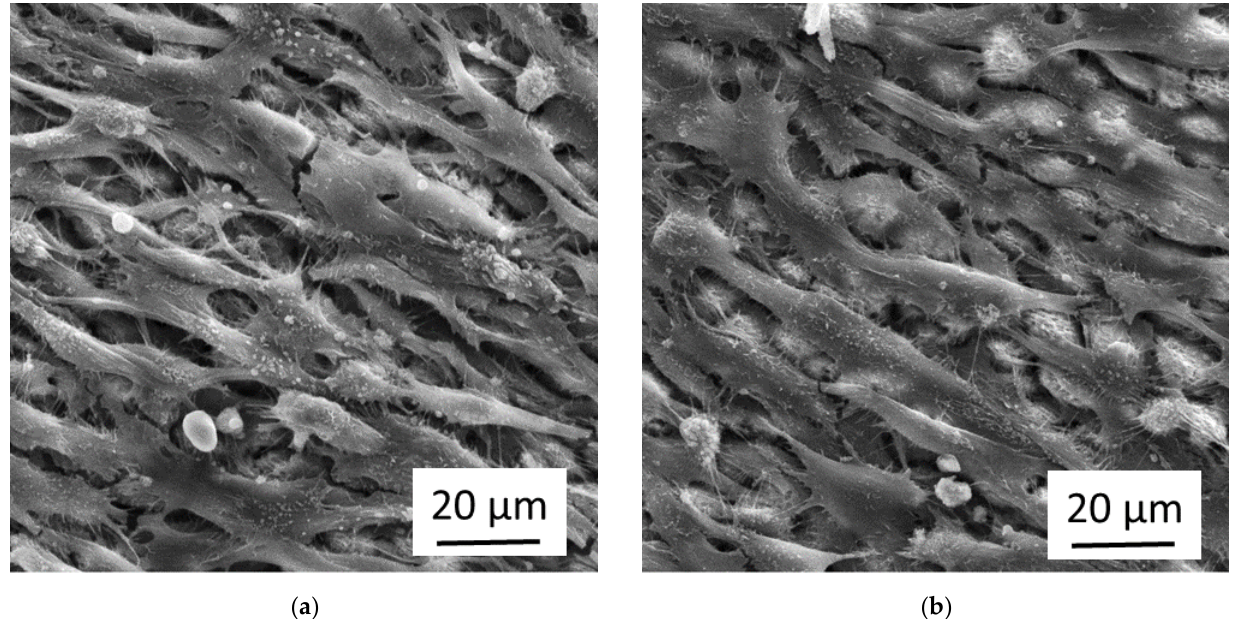
Figure 5. SEM images with higher magnification of the growth of osteoblasts at femtosecond laser-processed Ti-6Al-4V samples with and without sub-sequent anodization. ( a ) Femtosecond laser-processing without anodization; ( b ) Femtosecond laser-processing followed by anodization.